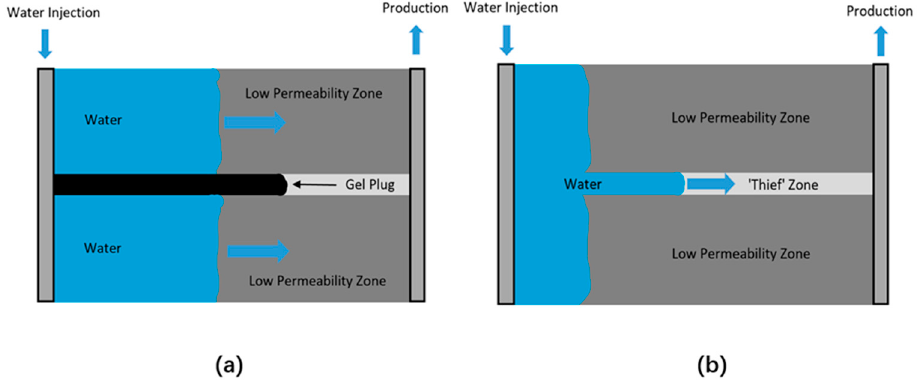
Figure 13. Water flooding of a reservoir with heterogeneous permeability with ( a ) or without ( b ) polymer plugging.